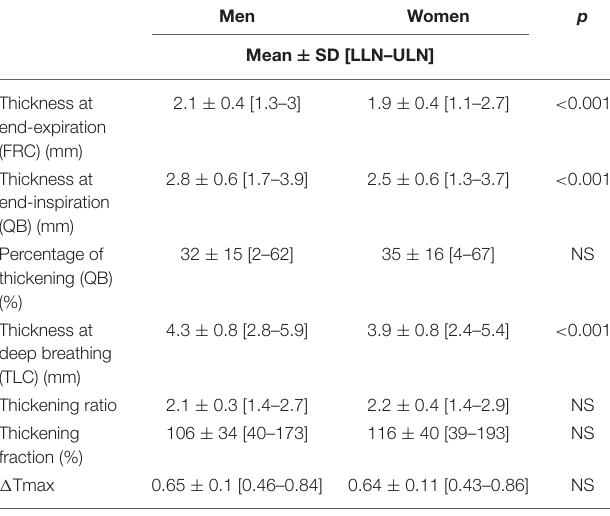
TABLE 2 | Study of the right hemidiaphragm.